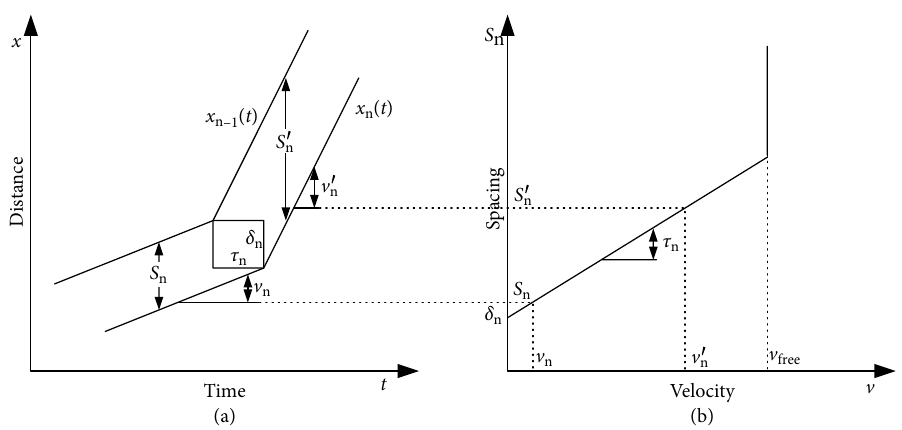
Figure 2: Schematic diagram of Newell’s car-following model. (a) The trajectories of leading vehicle and the follower’s. (b) The relationship between spacing and velocity in Newell’s model.